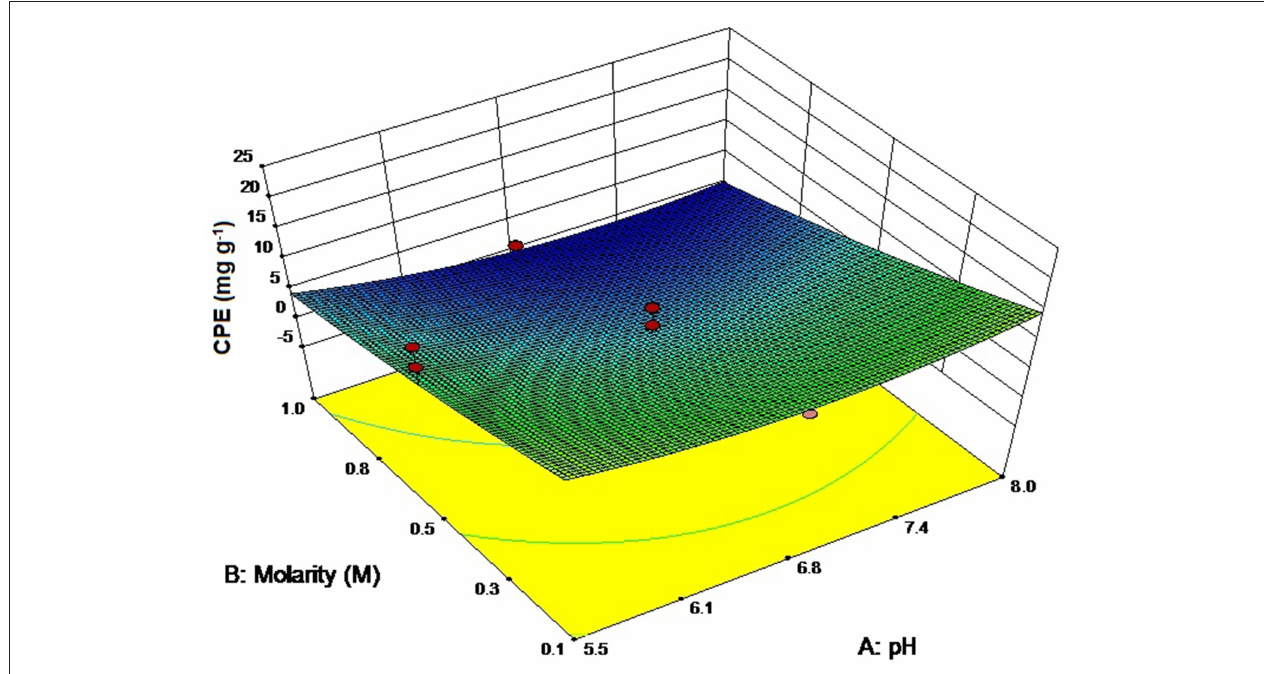
FIGURE 3 | Three-dimensional plot of interaction between pH and buffer molarity for CPE extraction.